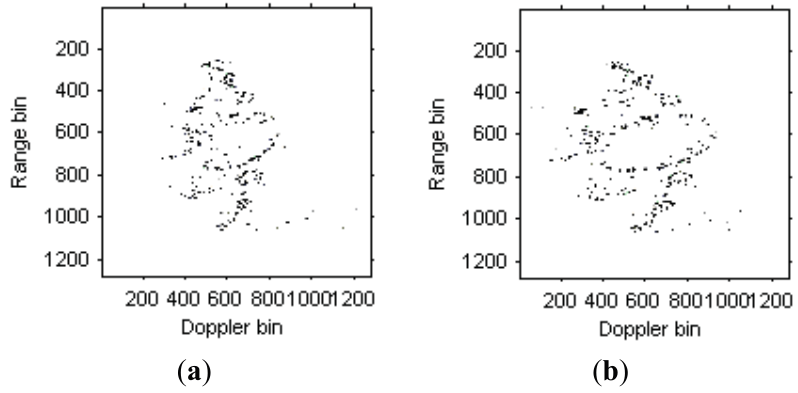
Figure 8. Radar images based on LFM signal model. ( a ) Radar image at time t = 0.17 s; ( b ) Radar image at time t = 0.22 s.